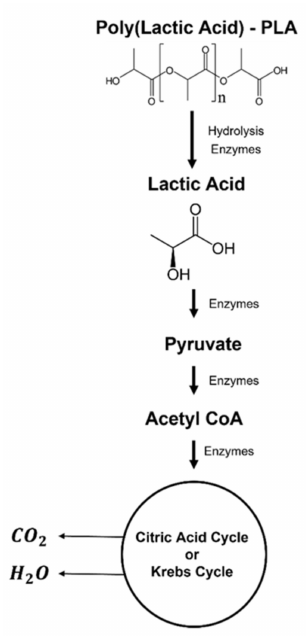
Figure 6. PLA biodegradation